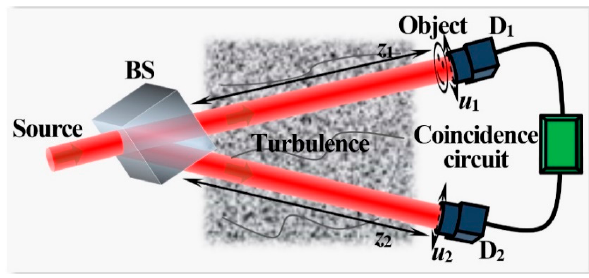
Figure 1. Schematic setup for lensless ghost imaging through turbulence. BS, beam splitter; D 1 , bucket detector; D 2 , single-photon detector.